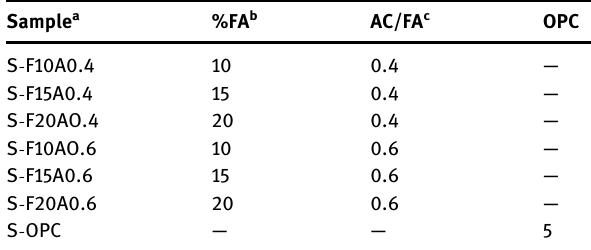
Table 3: Details of mixtures used